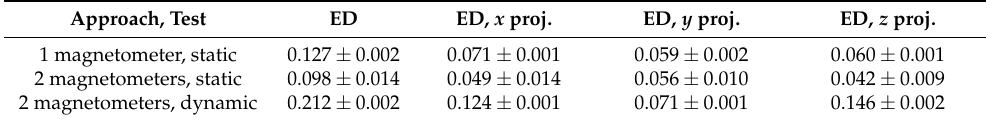
Table 2. Mean and standard deviation in mm of the Euclidean distance (ED) and its projections on different axes with current and previous approaches. Approach, Test ED ED, x proj. ED, y